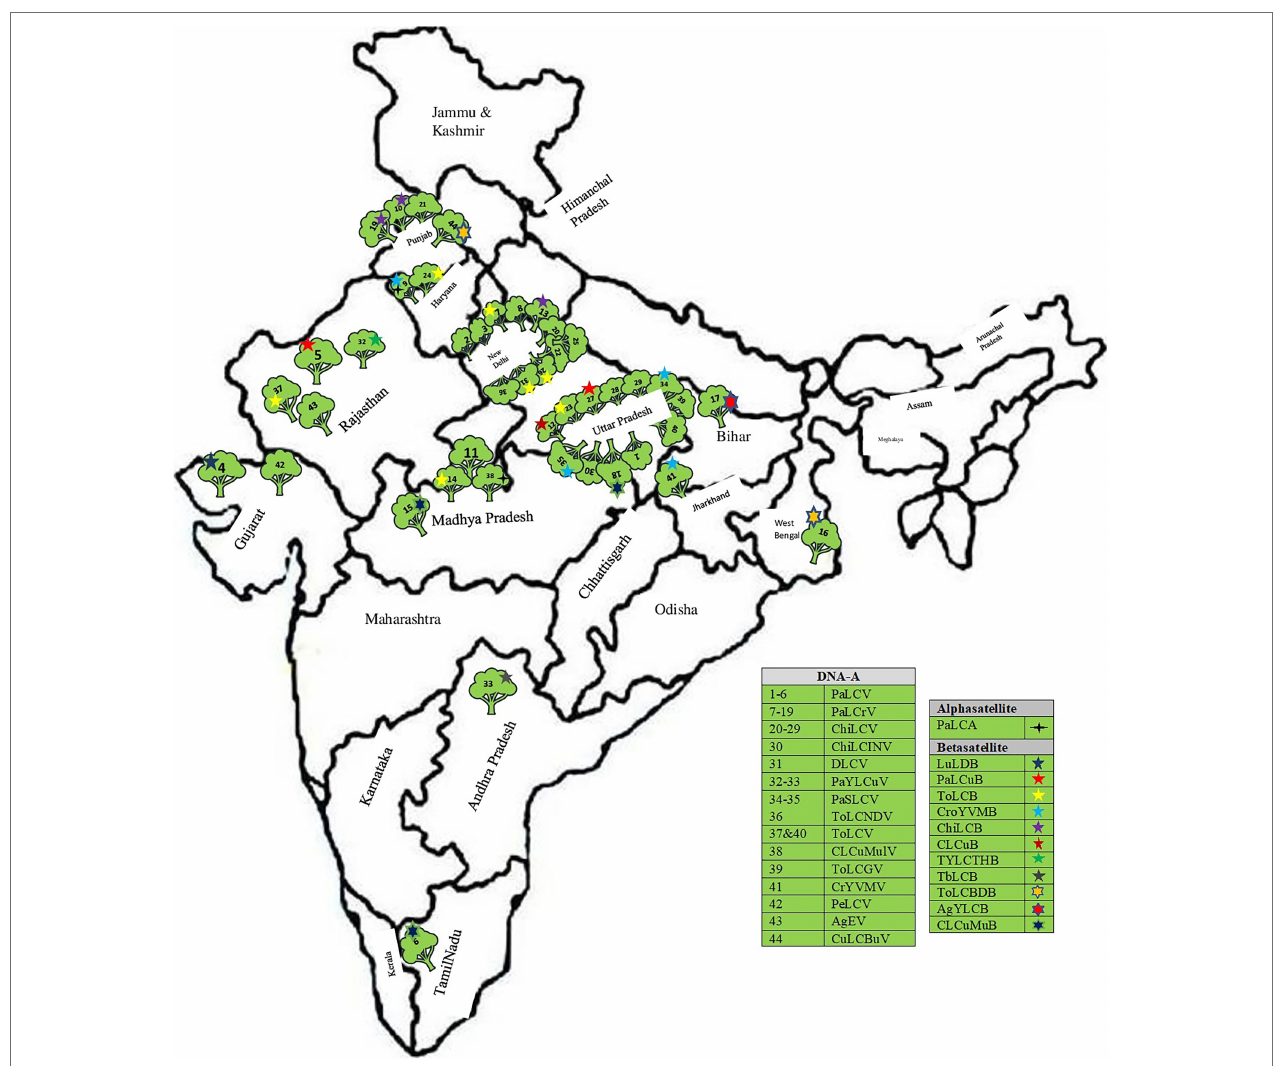
FIGURE 4 | Distribution of distinct begomoviruses isolates and their satellites in India associated with leaf curl disease of Carica papaya (Follow Table 1